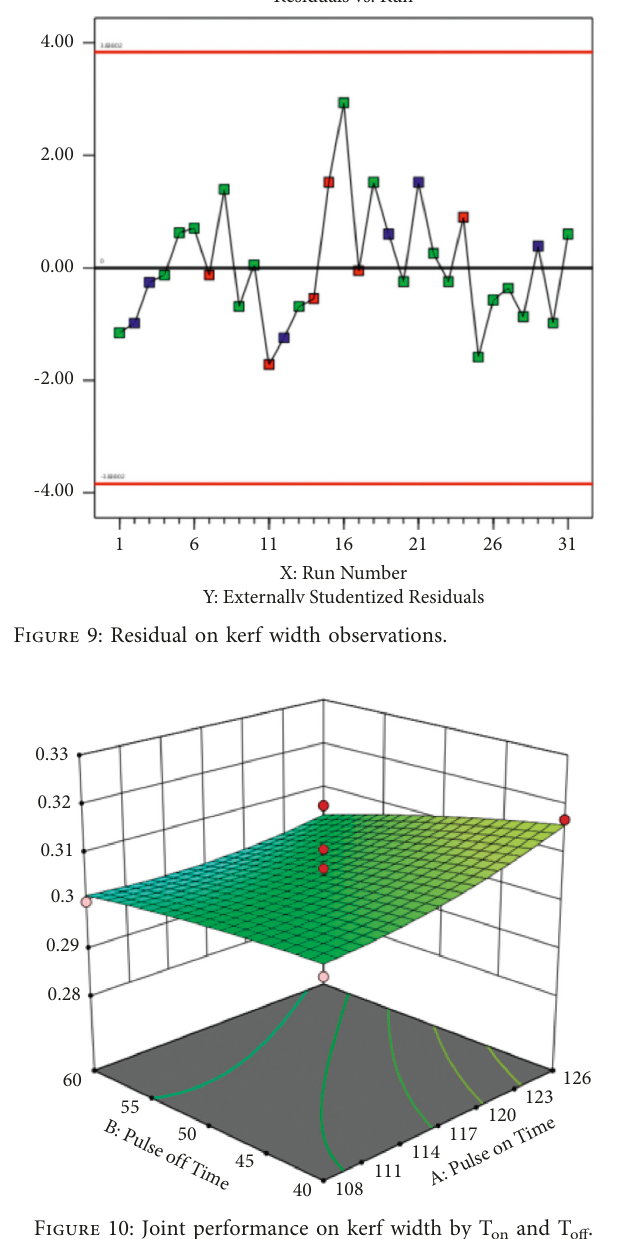
Figure 10: Joint performance on kerf width by T